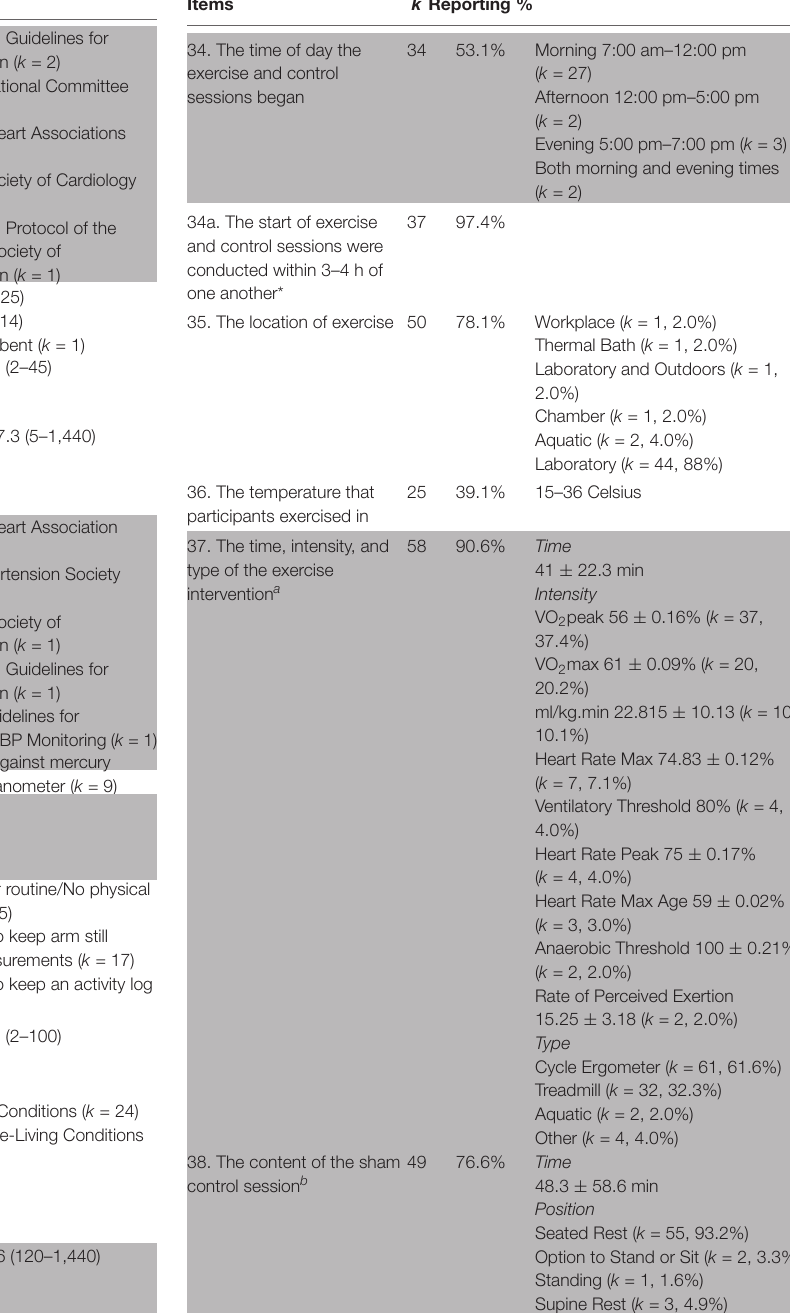
√ list part three intervention TABLE 3 | PEH